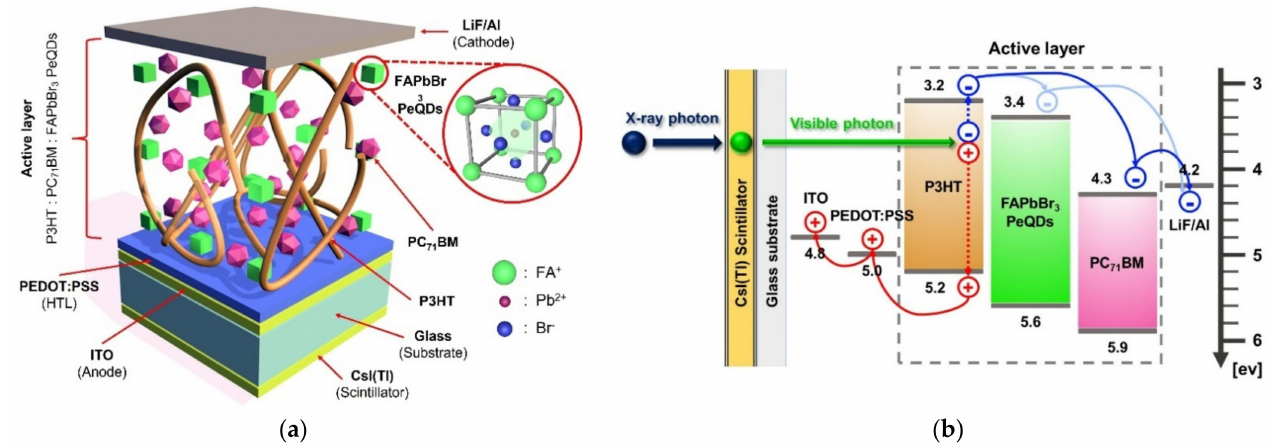
Figure 1. ( a ) Schematic and ( b ) energy band diagram of the X-ray detector with P3HT:PC 71 BM:FAPbBr 3